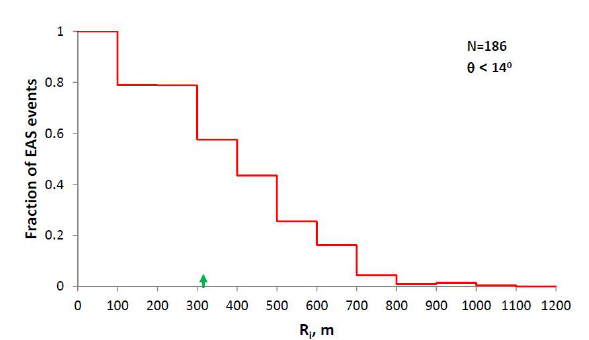
Figure 2. Energy dependence of Full width at half-maximum of the Cherenkov signal